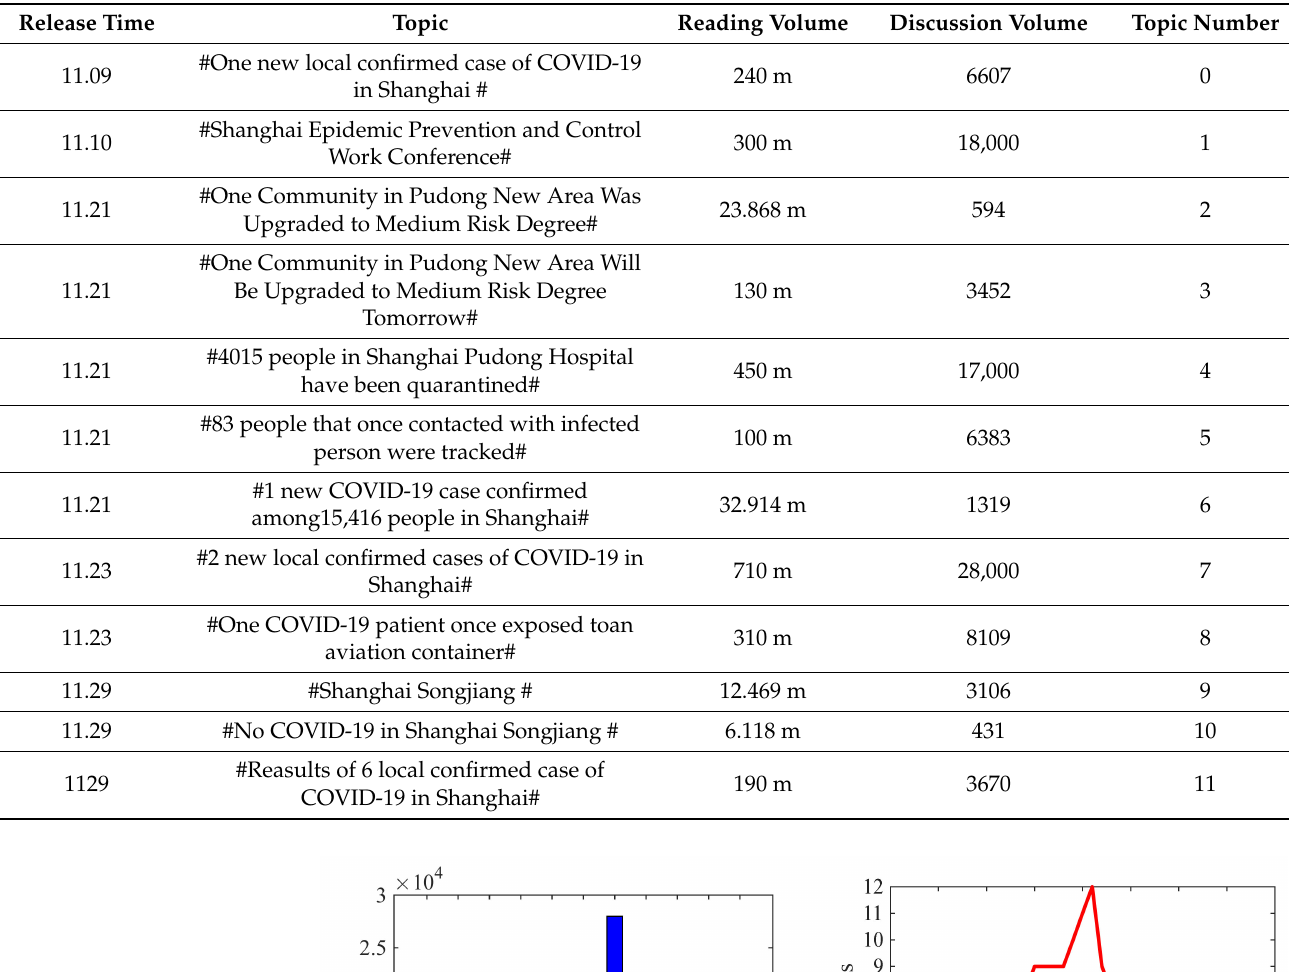
Table 4. Topic related to “Shanghai epidemic” public opinion.